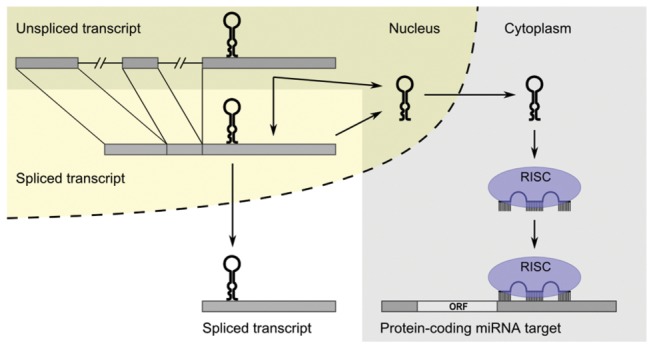
Model of processing of exonic primary miRNA transcripts.The classical miRNA processing and functioning pathway (indicated in dark) shows that the predominant pri-miRNA transcript, i.e. the unspliced nuclear transcript, is processed to pre-miRNA. Pre-miRNA is transported to the cytoplasm and further processed to mature miRNA. Mature miRNA guides the RNA-induced silencing complex (RISC) to protein-coding miRNA targets to inhibit their expression. Unspliced transcripts can also be spliced before being processed to pre-miRNA. Alternatively, the spliced transcript can also be transported to the cytoplasm. This may represent a mechanism to prevent processing to pre-miRNA.